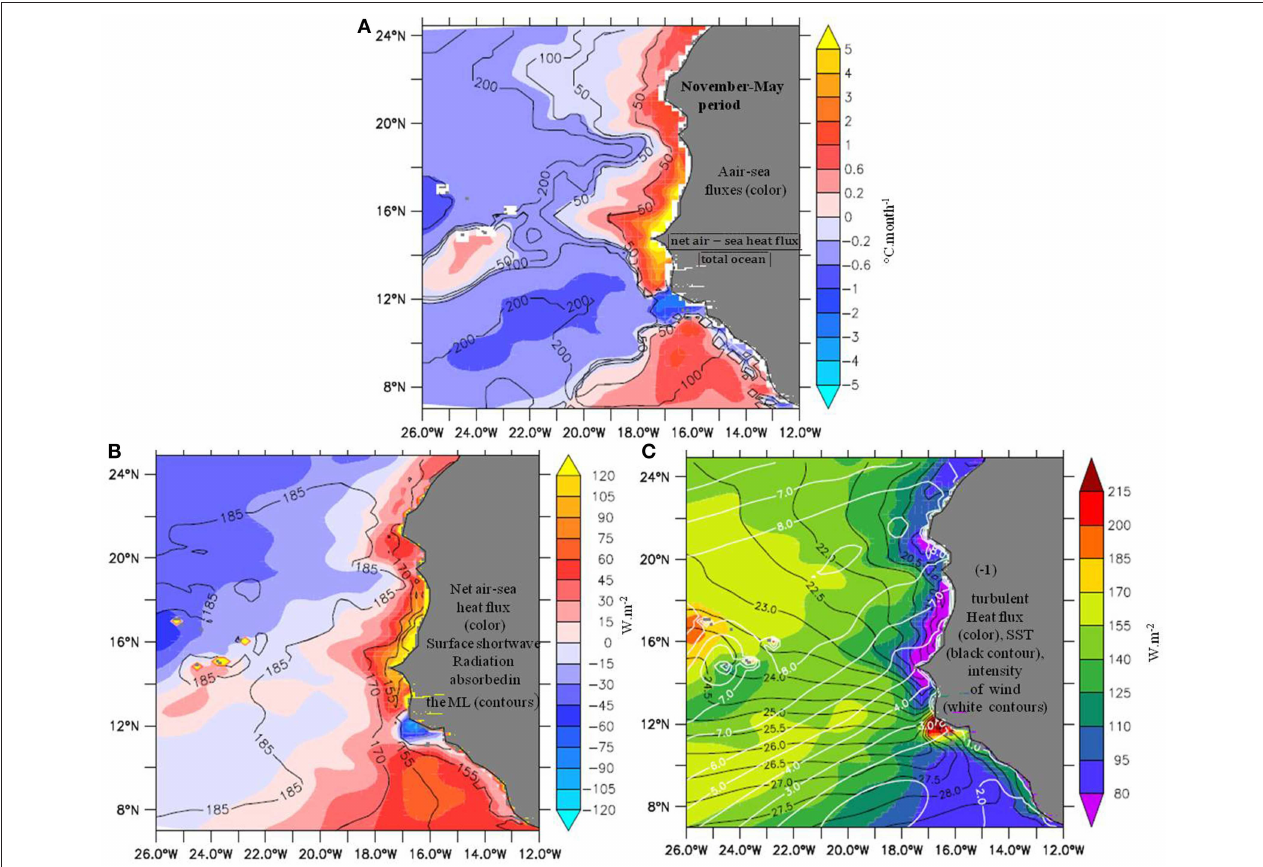
FIGURE 9 | Contribution of air-sea heat fluxes to the ML heat budget over the CP. (A) trend associated with the net air-sea heat flux (shading, ◦ C.month − 1 ) and ratio of net air-sea heat fluxes effect over total ocean effect (black contours), (B) net air-sea heat flux (shading, W.m − 2 ) and surface shortwave radiation absorbed in the ML (black contours), (C) turbulent heat fluxes (latent + sensible) (shading, W.m − 2 ), SST (black contours, ◦ C) and intensity of wind stress (white contours, N.m − 2 ). The sign of latent heat flux ( < 0) has been